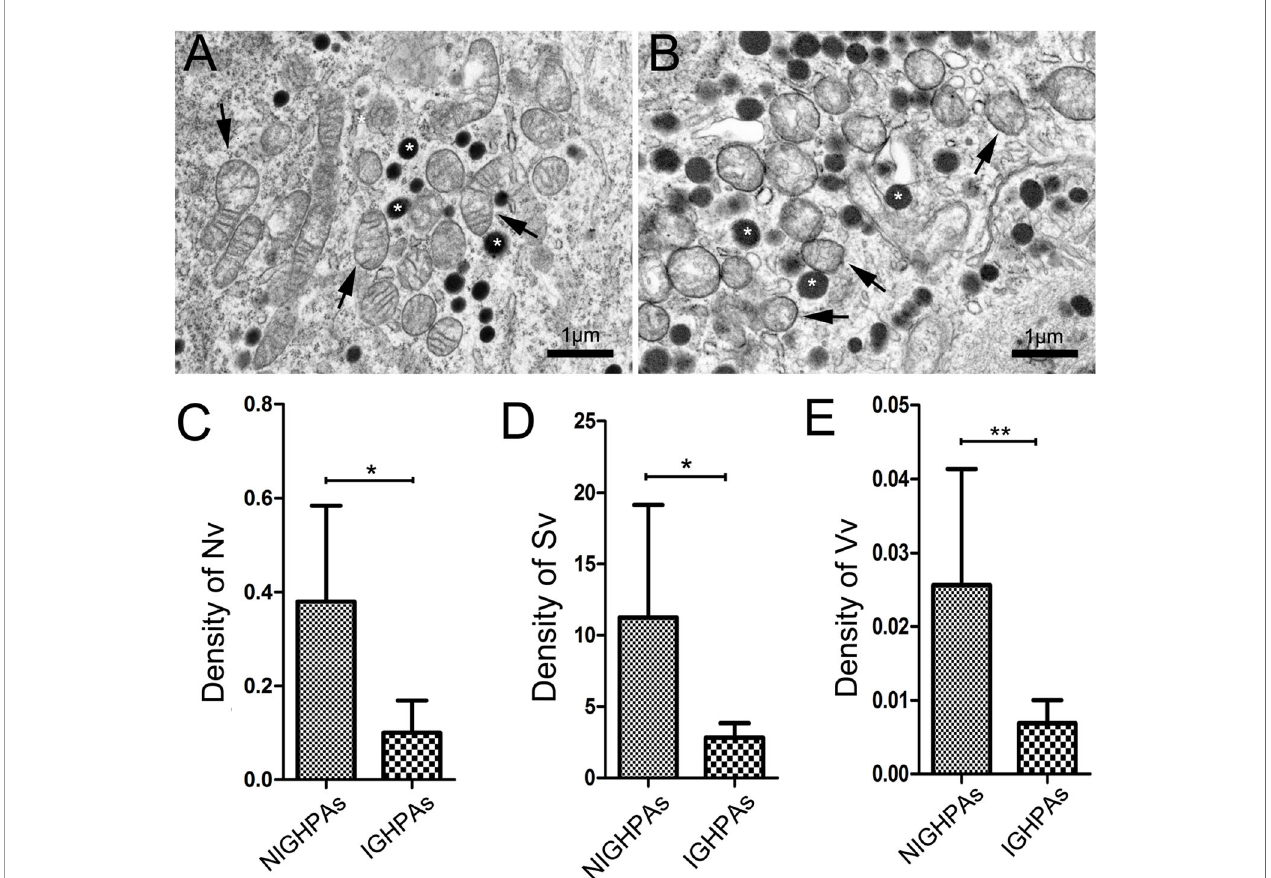
FIGURE 1 | Stereological analysis of mitochondria in NIGHPAs (n = 7) and IGHPAs (n = 7). The number density, bulk density and surface area density were corrected with tumor volume measured by nuclear magnetic resonance. Nonparametric tests were used for statistical analysis. (A) Representative electron microscopic image of tumor cells in NIGHPAs. Several mitochondria with normal morphology (arrows) and secretory granule (stars) were observed. (B) Representative electron microscopic image of tumor cells in IGHPAs. Several swollen mitochondria (arrows) and secretory granule (stars) were observed. (C) The density of mitochondrial number (Nv) in IGHPAs was signi fi cantly lower than that of NIGHPAs. (D) The density of mitochondrial surface area (Sv) in IGHPAs was signi fi cantly lower than that of NIGHPAs. (E) The mitochondrial volume fraction (Vv) in IGHPAs was signi fi cantly lower than that of NIGHPAs. Scale bar = 1um, *P < 0.05, **P <